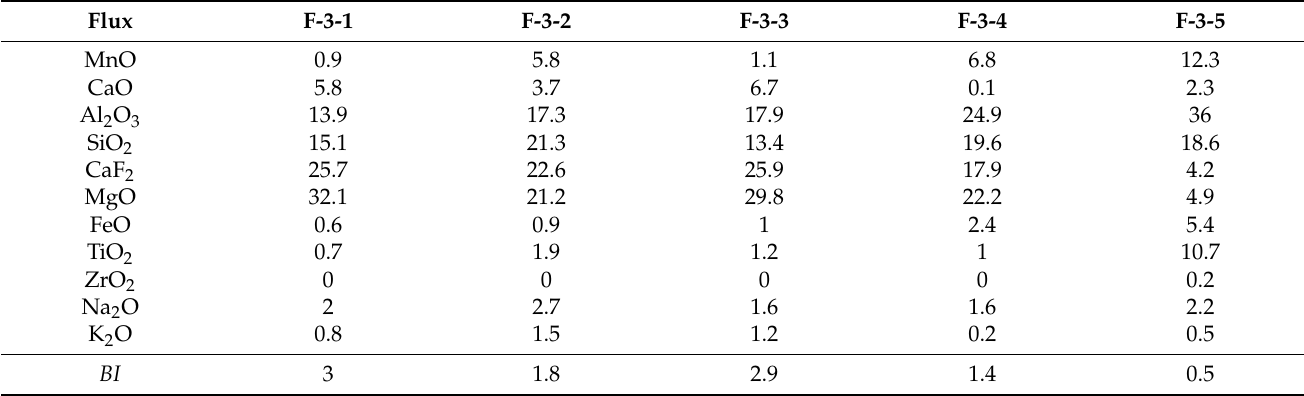
Table 3. Flux formulas subject to typical commercial fluxes